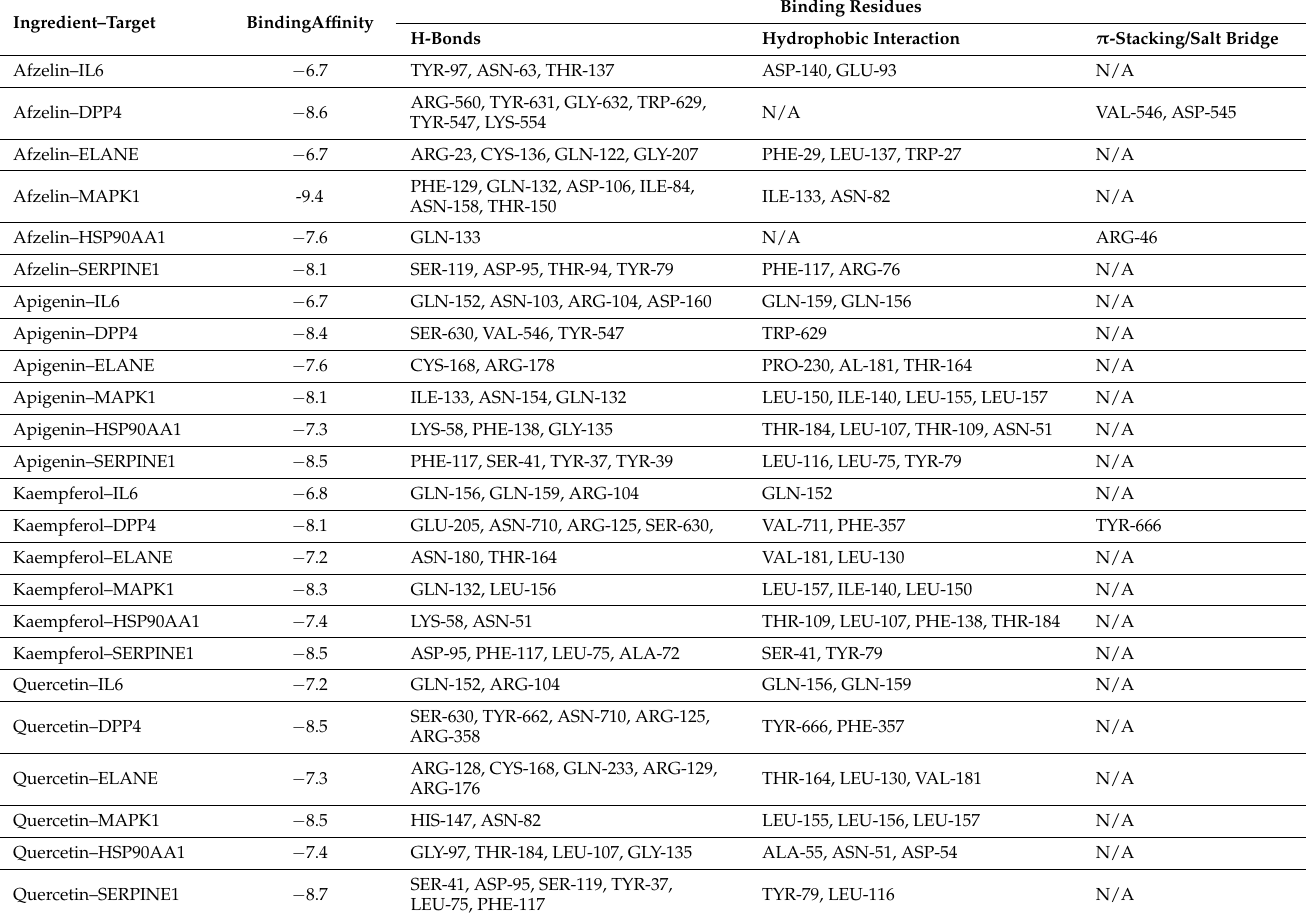
Table 4. Binding affinities (kcal/mol) and binding